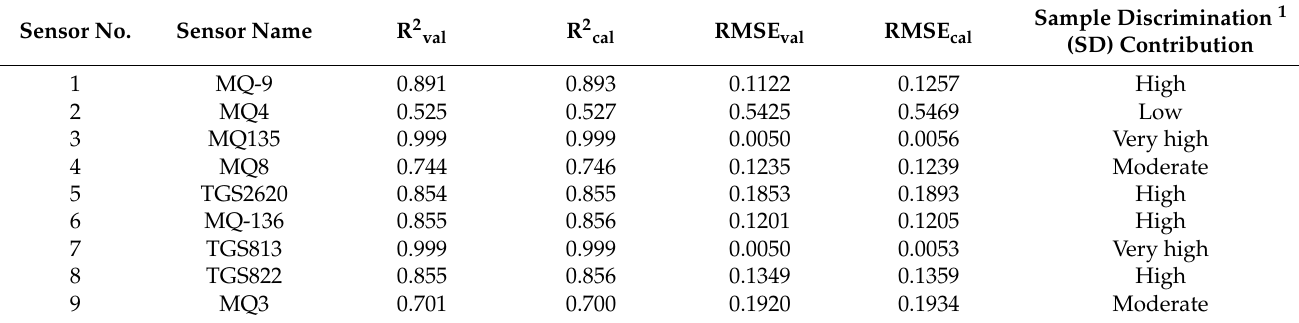
Table 3. Principal-regression model analysis results for individual sensors of the MAU-9 sensor array. Sensor No.